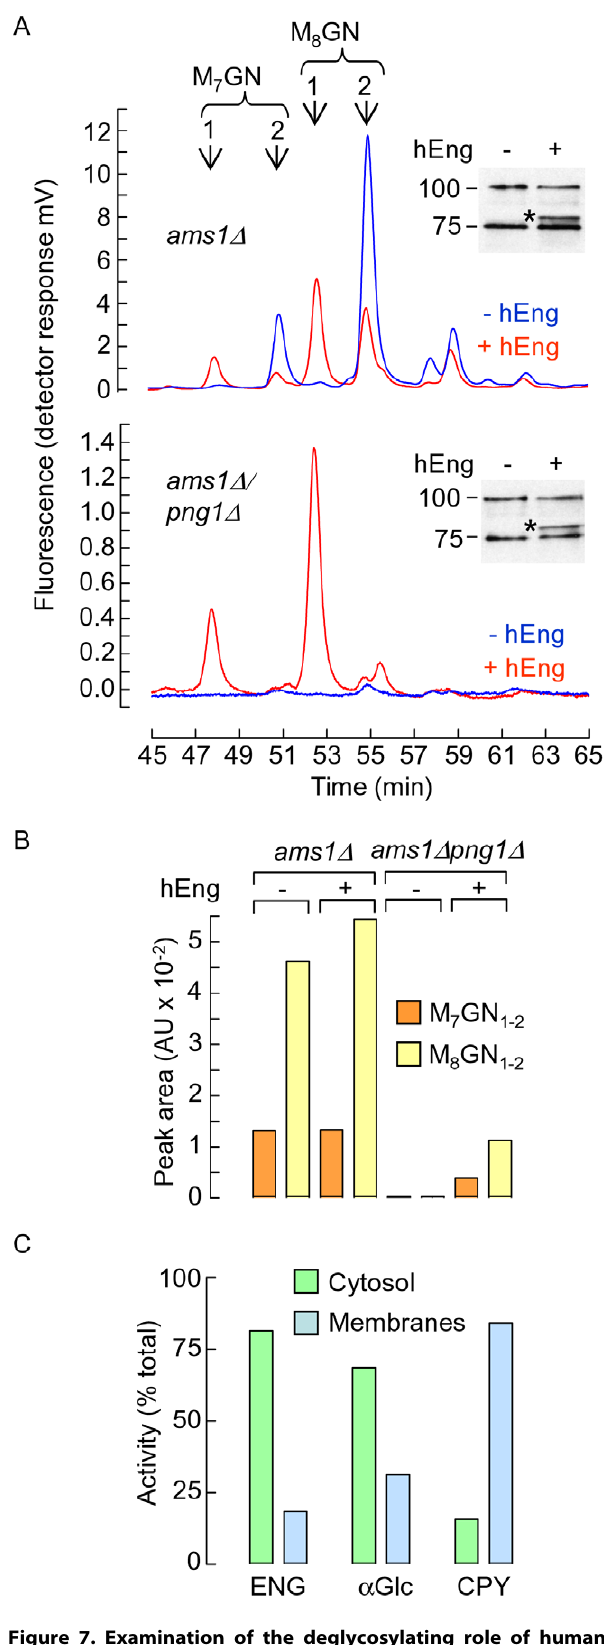
Figure 7. Examination of the deglycosylating role of human Engase1p in Png1p-deficient yeast cells. A. Obtention of the S. cerevisiae ams1 D and ams1 D png1 D strains, deficient in the